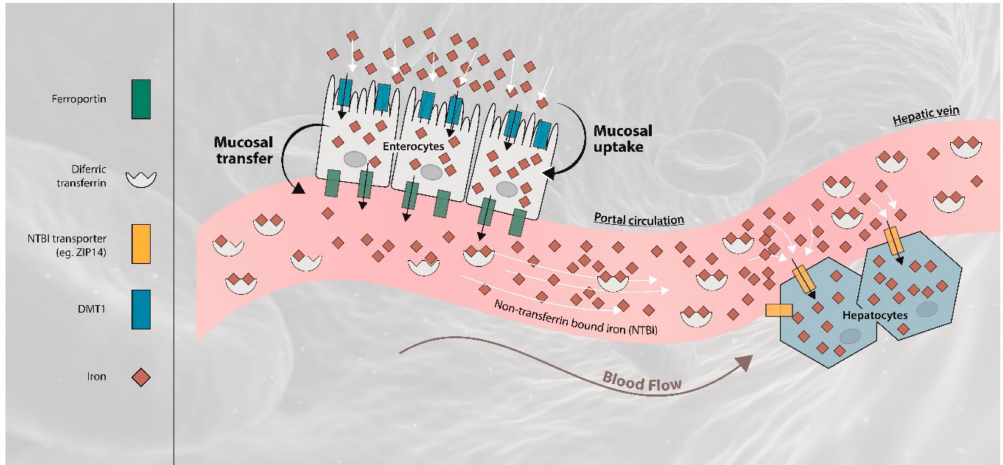
Figure 4. Continuous iron loading in primary or secondary hemochromatosis. Simplified visualization of iron absorption and first passage of the liver. Iron absorption in iron-overload results in generation of NTBI, including LPI. The majority of LPI produced in the portal system is taken up in the liver in the first-pass. DMT1 divalent metal transporter 1; NTBI non-transferrin bound